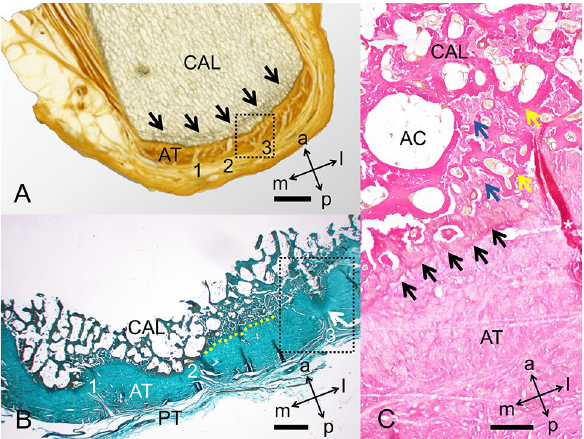
Figure 7. The insertion of the Achilles tendon (AT) into the calcaneus (CAL) is depicted on plastinates and in histology. ( A ) Plastinated slice. Black arrows: demarcated trabeculae; dotted box: corresponds to an area similar to the dotted box in B; 1–3: fibrous septae, similar to the ones in B. Scale bar: 4 mm, ( B ) Masson–Goldner stain. Black box, median fibrous septum; PT, paratenon; 1–3: fibrous septae, similar to the ones in A; white arrow: median calcaneal prominence; yellow dotted line: demarcation between AT and CAL. Scale bar: 1 mm, ( C ) H&E stain. AC, adipocytes (located in bone marrow); black arrows: border between AT and CAL in greater detail compared to B; blue arrows: collagen bundles; white asterisk: folding artefact; yellow arrows: calcaneal trabeculae. Scale bar: 200 μm; a, anterior; l, lateral; m, medial; p,